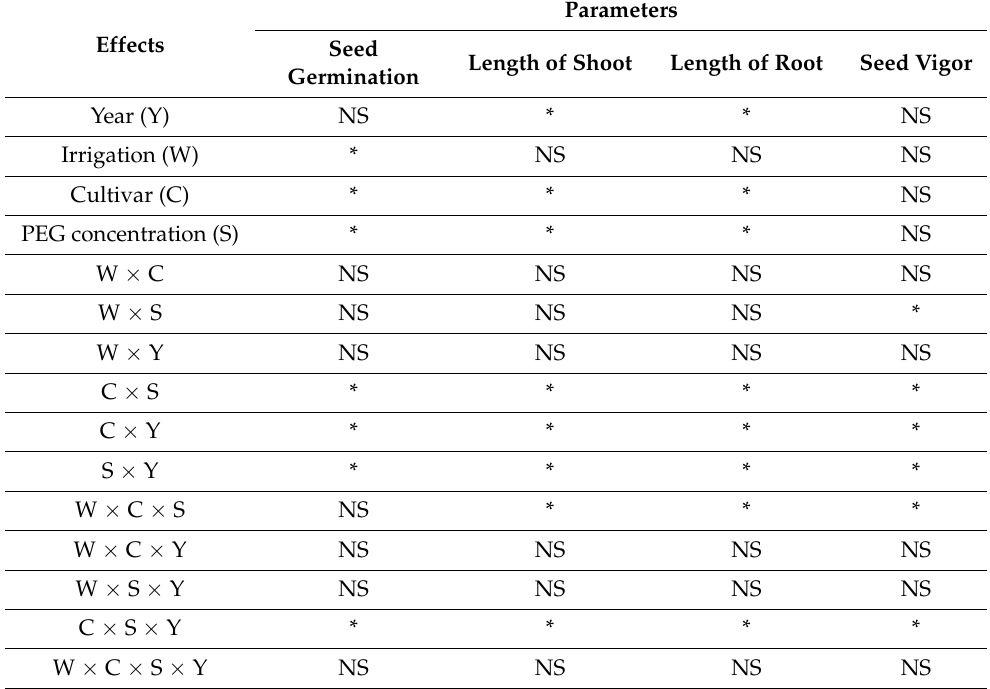
Table 2. Analysis of variance results (significance of the effects) for testing the effects (main and interactions) of year (Y), irrigation (W), PEG concentration of the solution (S) and cultivar (C) on the seed germination, length of shoot, length of root and seed vigor.